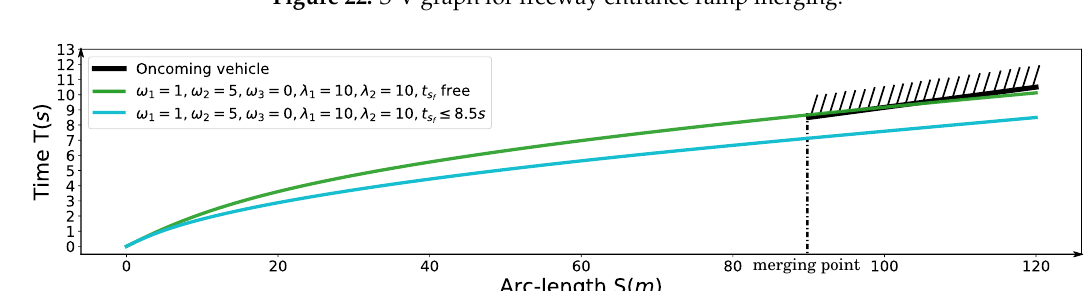
Figure 22. S-V graph for freeway entrance ramp merging.